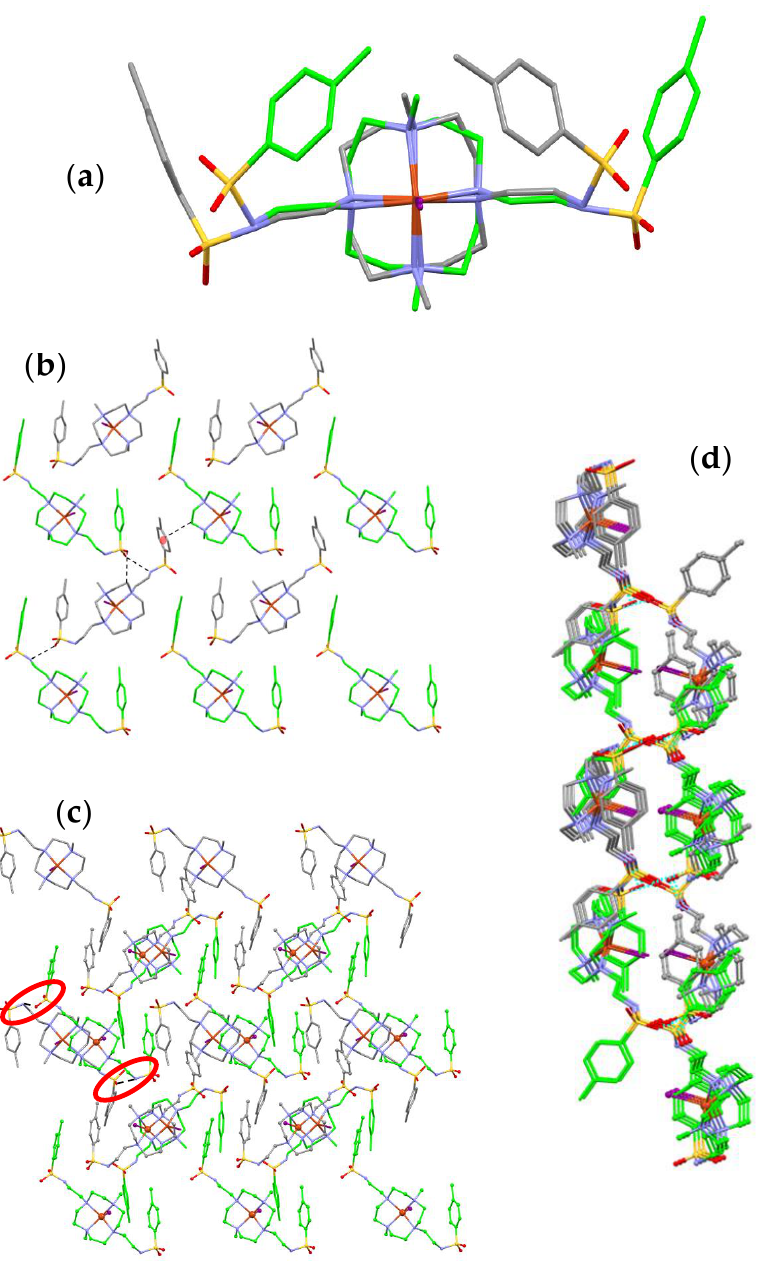
Figure 7. ( a ) Enantiomorphic nonequivalent complexes in the crystal structure of [Cu(L)I] 2 I 3 I 5 : conformations are related by a pseudo mirror plane. ( b ) In-plane H-bonding among [Cu(L)I] + complexes developing normal to c-direction. ( c ) Top view and ( d ) lateral view of the couple of planes formed by [Cu(L)I] + complexes developing parallel to the c-direction; red-circled, out-of-plane